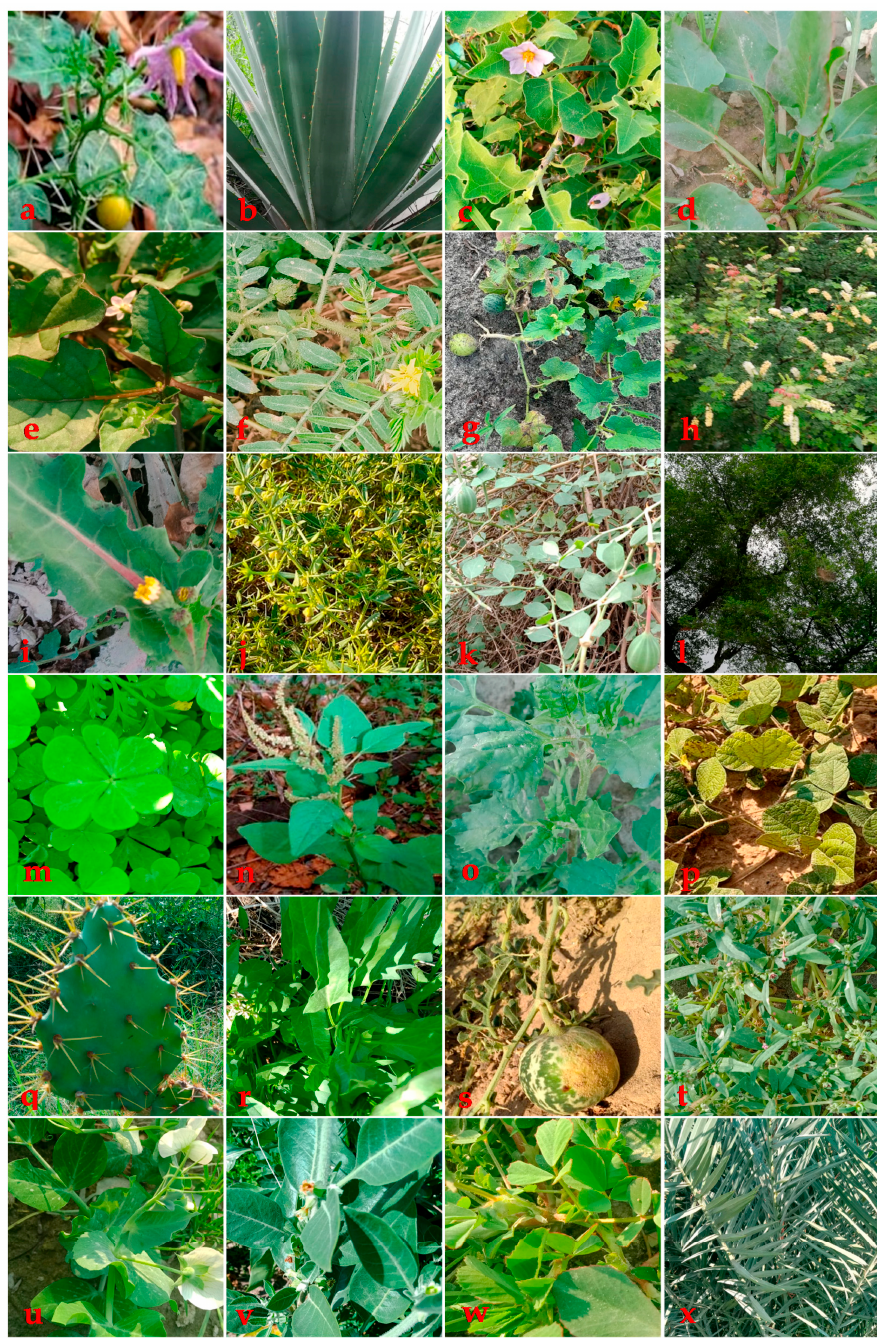
Figure 4. Some examples of wild food plants of Jhelum district: ( a ) Solanum surattense ; ( b ) Agave americana ; ( c ) Solanum incanum ; ( d ) Rumex dentatus ; ( e ) Solanum americanum ; ( f ) Tribulus terrestris ; ( g ) Cucumis melo ; ( h ) Acacia modesta ; ( i ) Sonchus asper ; ( j ) Fagonia indica ; ( k ) Capparis decidua ; ( l ) Ziziphus jujuba ; ( m ) Oxalis corniculata ; ( n ) Amaranthus spinosus ; ( o ) Chenopodium murale ; ( p ) Rhynchosia minima ; ( q ) Opuntia dillenii ; ( r ) Convolvulus arvensis ; ( s ) Citrullus colocynthis ; ( t ) Gisekia pharnaceoides ; ( u ) Lathyrus sativus ; ( v ) Withania coagulans ; ( w ) Trigonella corniculata ; ( x ) Phoenix sylvestris .